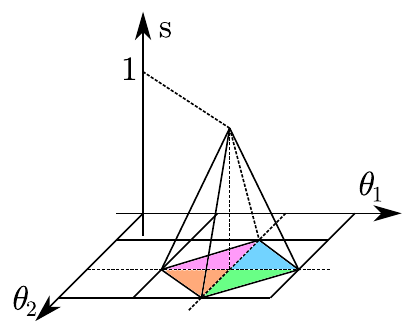
Figure 7. Generalization of the score function.